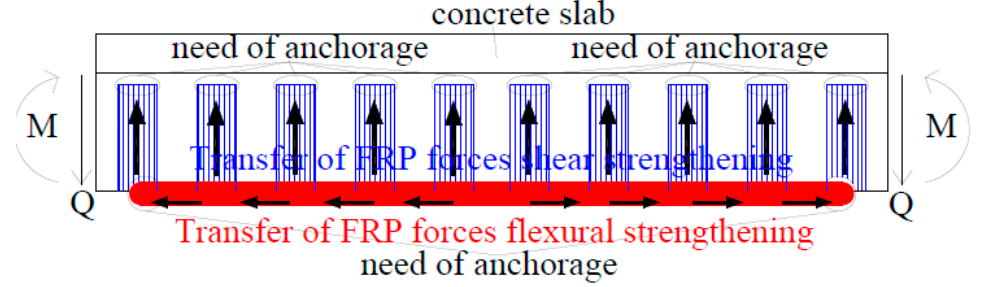
Figure 4. Force transfer mechanisms for externally bonded FRP strips either for flexural or shear retrofit.